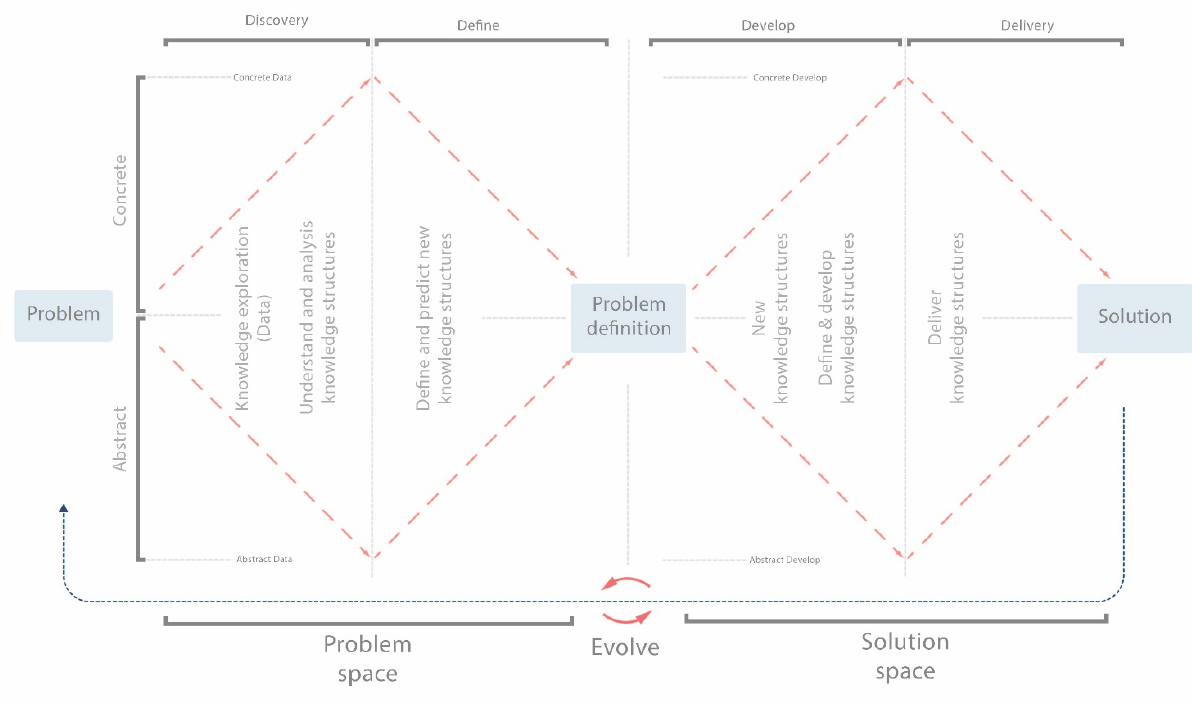
Fig. 5: Data-driven design model